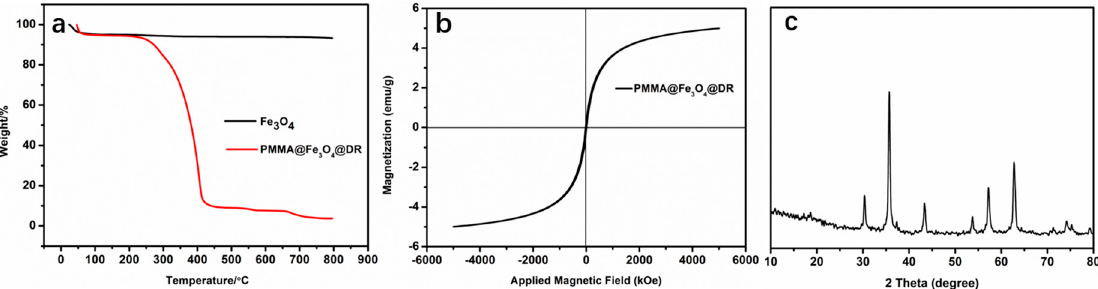
Figure 5. TGA (Thermogravimetric analysis) curves ( a ); magnetization curves ( b ) of magnetic microspheres and XRD (X-ray diffractometer) patterns of Fe 3 O 4 ( c ).